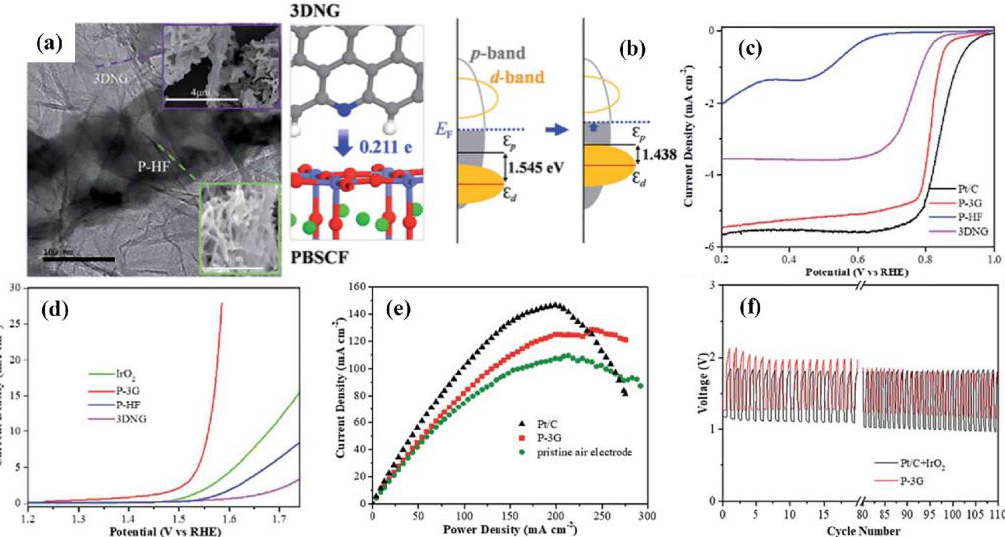
Figure 3. ( a ) TEM image of P-3G; ( b ) The charge transfer from 3DNG to PBSCF (left) and the schematic band diagrams of PBSCF and PBSCF with 3DNG (right); ( c , d ) ORR and OER LSV curves; ( e ) Power density curves; ( f ) Discharge and charge cycling curves of rechargeable ZABs based on P-3G and Pt/C+IrO 2 at a current density of 10 mA cm −2 [77]. Copyright 2018, the Royal Society of Chemistry.